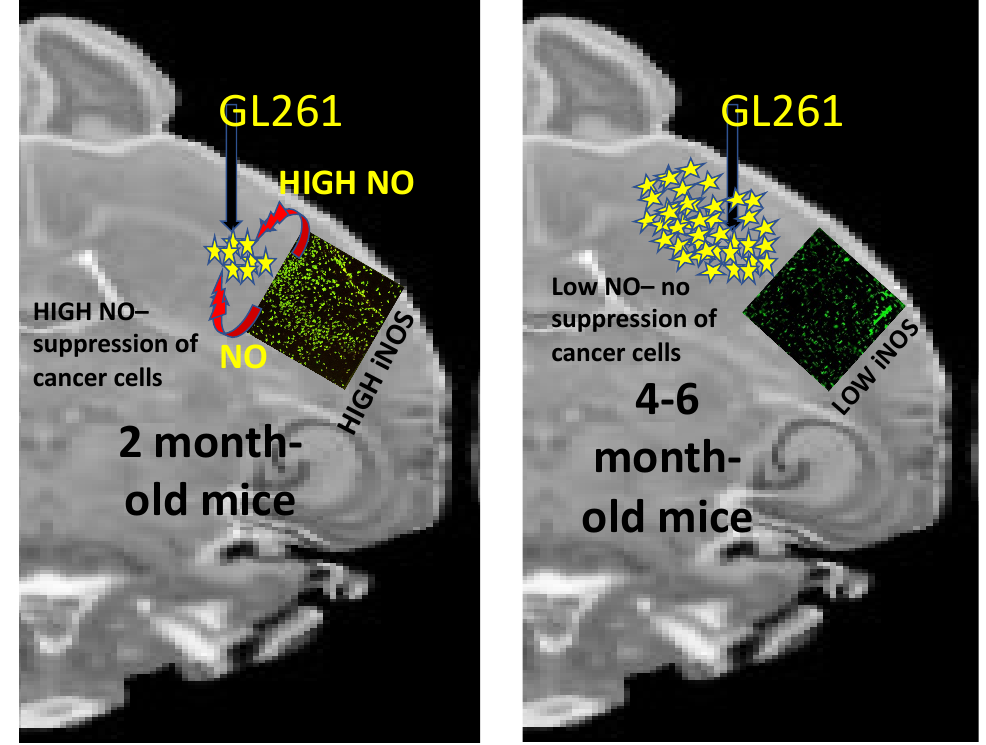
Figure 3. The likely reason for tumor resistance in the brain of 2-month-old mice (The stars represent GL261 GBM cells).